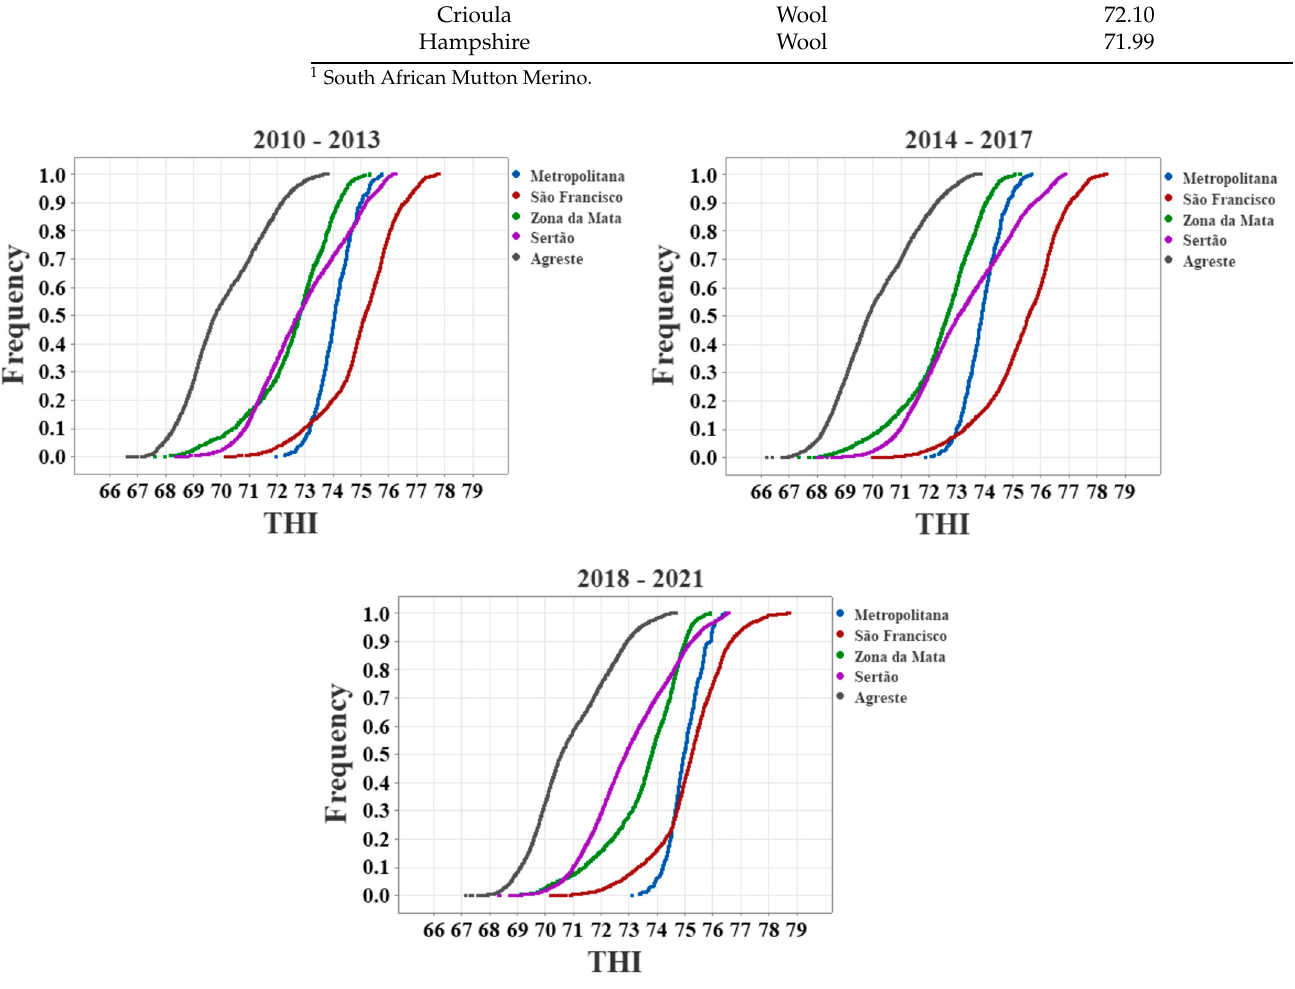
Figure 4. Cumulative distribution functions of the four-year THI values in Pernambuco state.